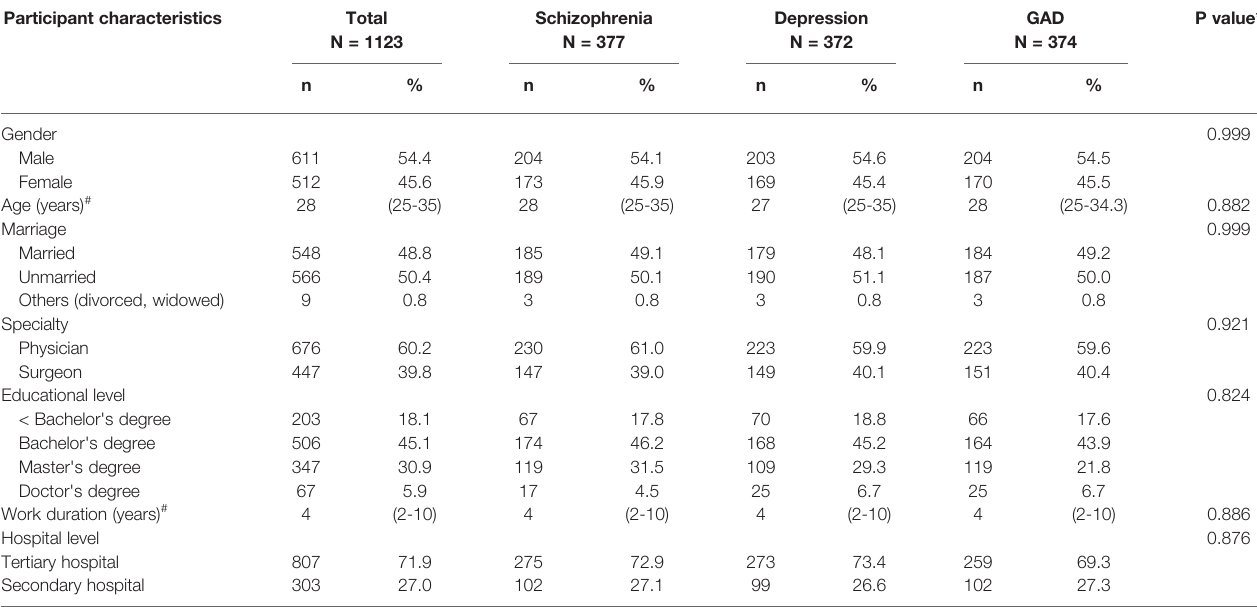
*P-value was calculated for different vignettes, with Chi-square test for categorical variables and Kruskal-Wallis test for continuous variables. # Data descriptive with median (interquartile